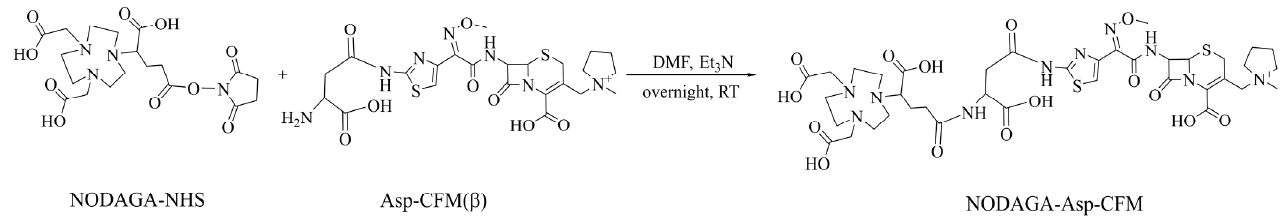
Figure 3. HPLC chromatogram (at 270 nm) of deprotection reaction mixture of Fmoc-Asp-CFM de- rivative in 2.5% piperidine solution after 30 min; isomer Asp-CFM( α ) with R T = 18.68 min and isomer Asp-CFM( β ) with R T = 19.33 min (gradient 2).